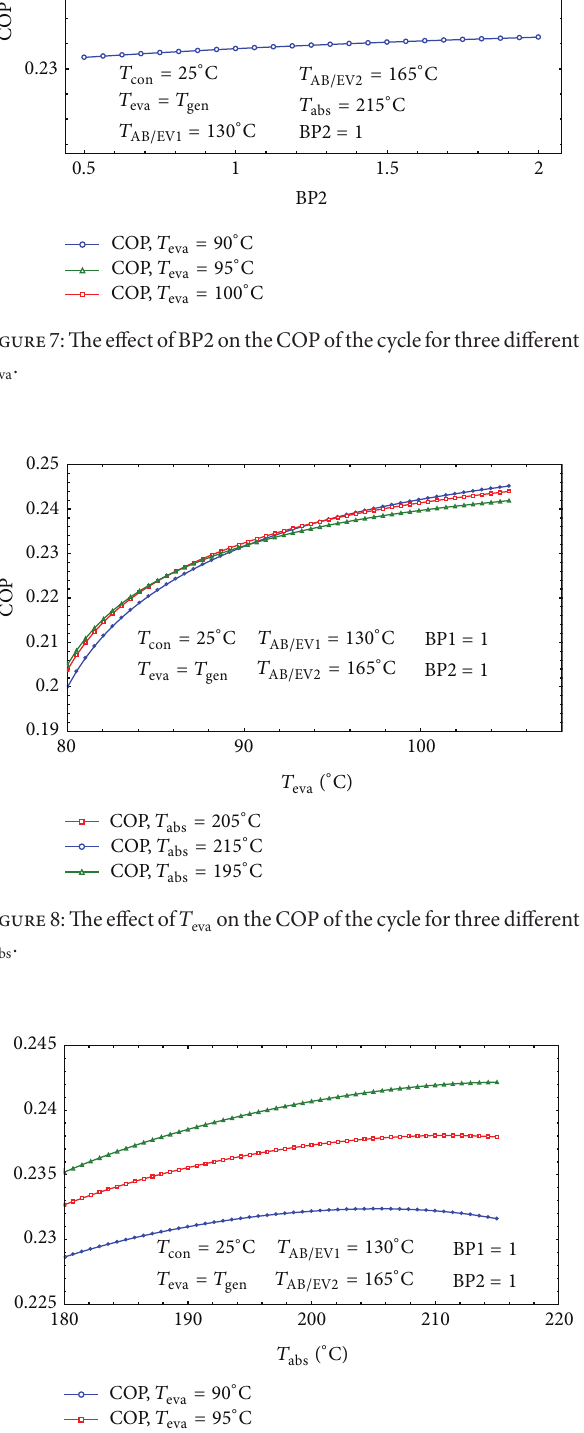
ontheCOPofthecycleforthreedifferent abs